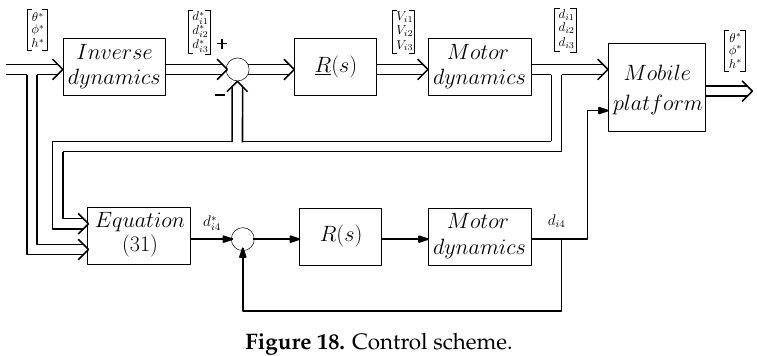
Figure 18. Control scheme.